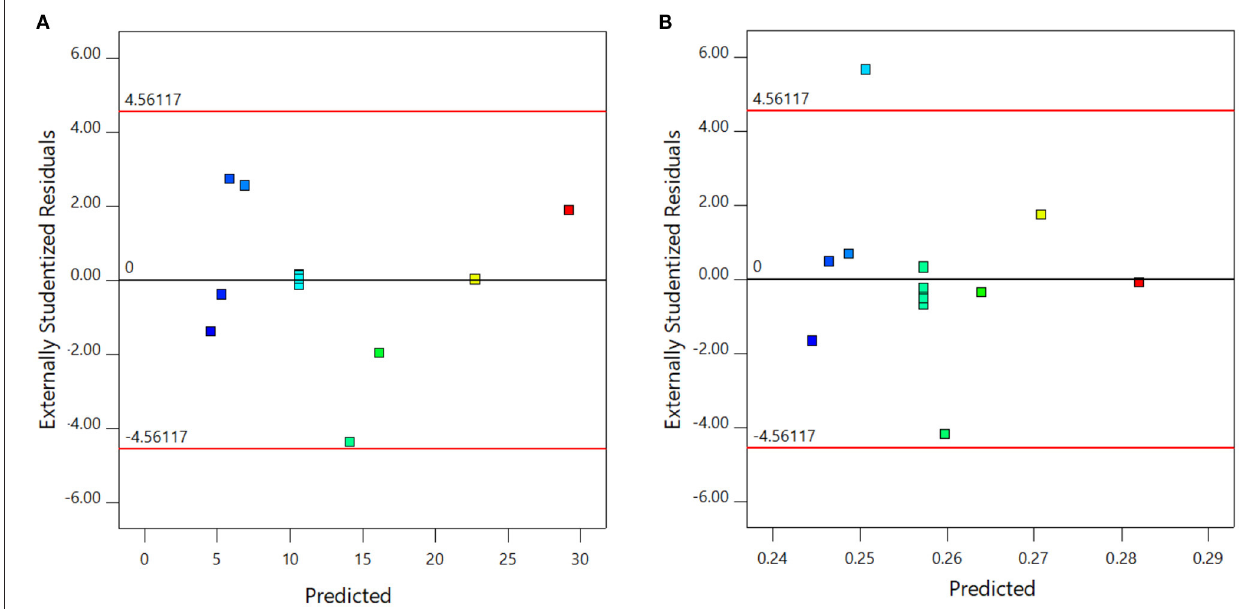
FIGURE 2 | Externally studentized residual plots for (A) viscosity and (B) thermal conductivity.